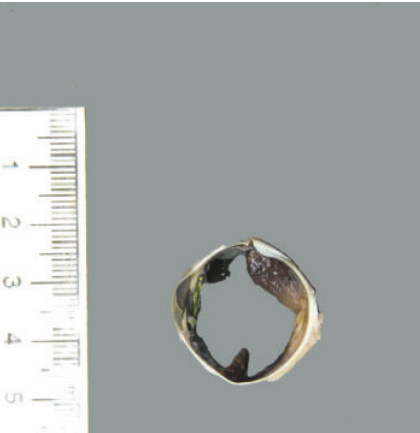
Figure 1: Gross photomicrograph depicting pupil-optic nerve (PO) section of enucleated eye which reveals diffuse thickening of the iris and part of the choroid layer.